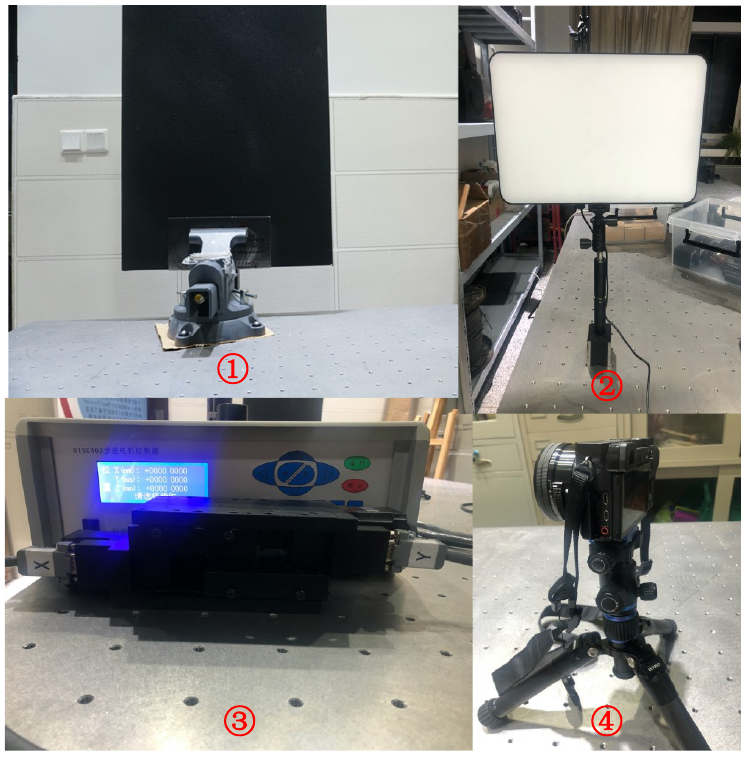
Figure 12. Experimental system.